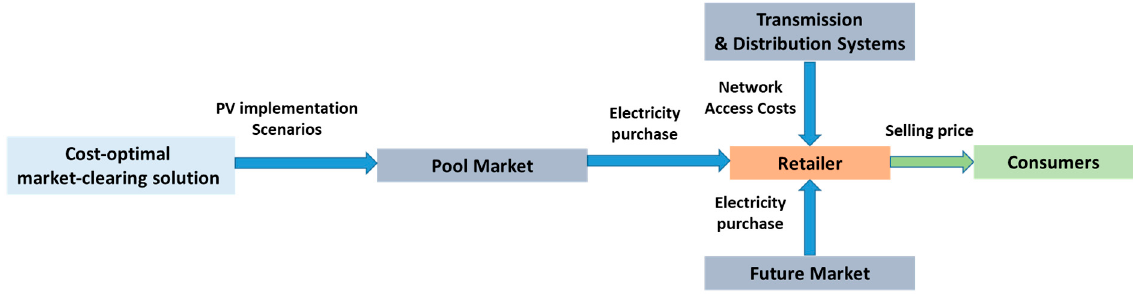
Figure 1. Visual description of the proposed model. (source: Authors).